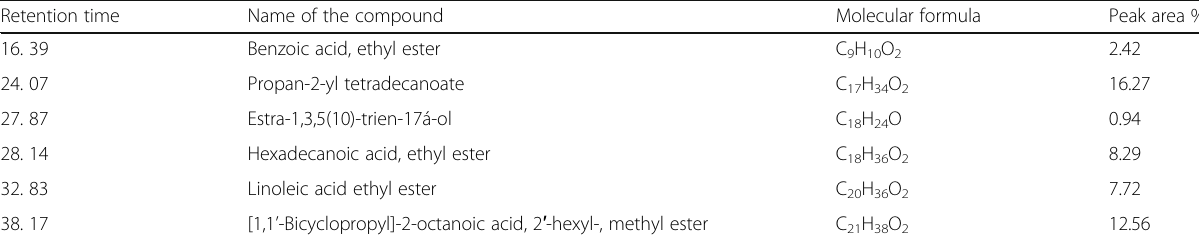
Table 7 GC-MS data of ethanol bark extract of Flacutia indica Retention time Name of the compound Molecular formula